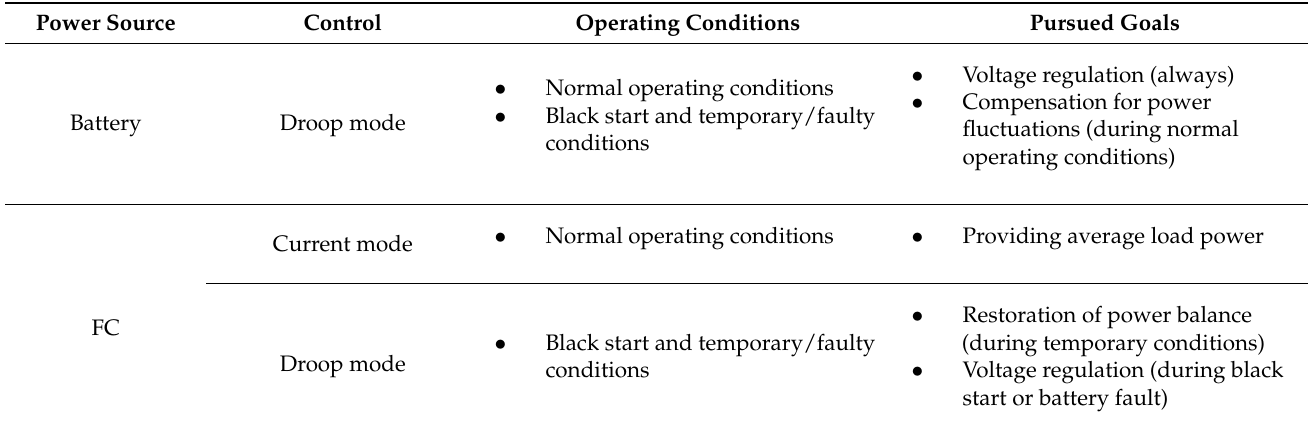
Table 3. Control modes of the FC and battery converters.